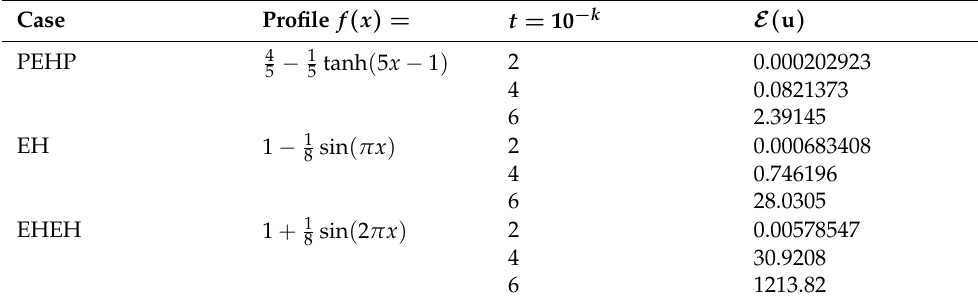
Table 2. Reference data (1D) on